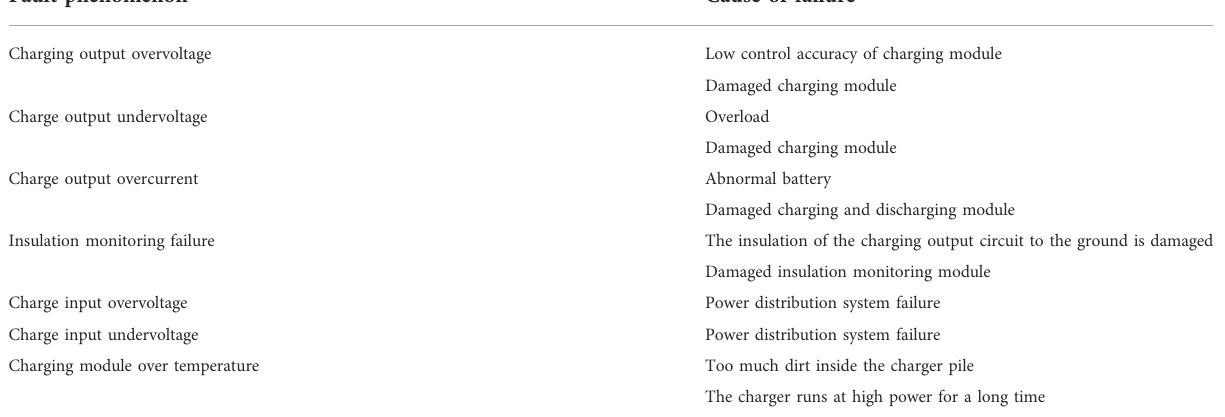
TABLE 2 Fault phenomenon and cause of DC